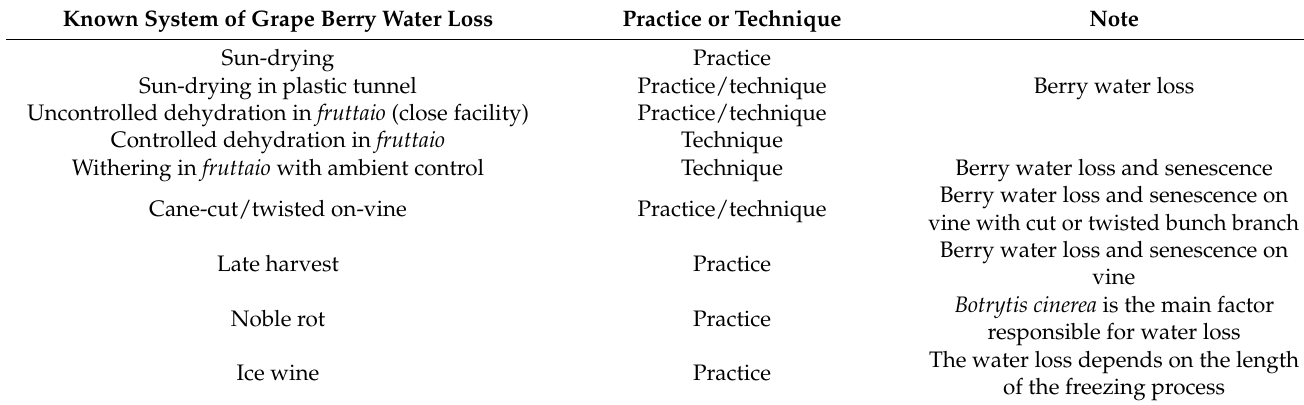
Table 1. List of known systems applied to induce grape water loss to produce